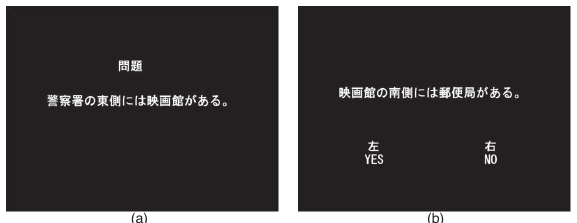
Figure 1. The screen on the left (a) shows a sample of a definition statement: “A theater is located on the east side of the police station.” The screen on the right (b) shows a sample of a question statement: “There is a post office on the south side of the theater.”